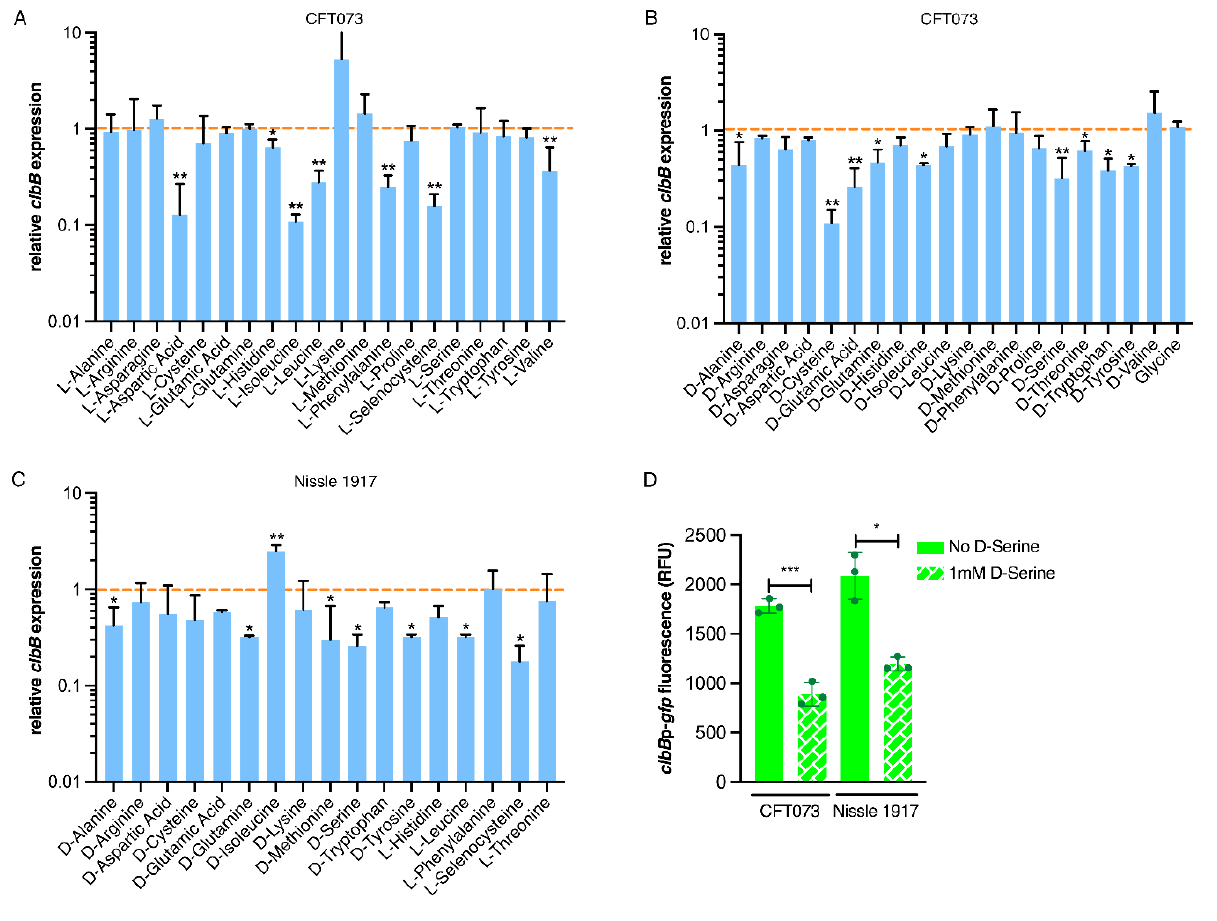
FIGURE 2: Expression of colibactin is modulated by L- and D-amino acids. Relative clbB expression was measured by RT-qPCR. CFT073 was grown in M9 minimal media supplemented with amino acids to a final concentration of 1 mM for 5 h. ( A ) Shows relative expression in the presence of L-amino acids and ( B ) indicates expression in the presence of D-amino acids. The orange dashed line indicates baseline expres- sion with bars above and below this line representing up and downregulation, respectively. Statistical significance was determined from three biological r eplicates using an unpaired Student’s t -test with, * and ** indicating significance, P < 0.05 and 0.01, respectively. ( C ) Amino acids significantly affecting clbB expression in CFT073 were tested in Nissle 1917 under the same growth conditions as discussed above. ( D ) clbBp :gfp reporter activity in MEM-HEPES in the presence and absence of 1 mM D-serine. Bacteria were sampled at 4 h post-inoculation, clbB expression was measured as GFP/OD 600 . Columns represent mean +/- standard error of the means (SEM) with individual experimental observations indicated by data points. Statistical significance was assessed using a paired Student’s t -test with *, ***, denoting P < 0.05 and 0.0001,